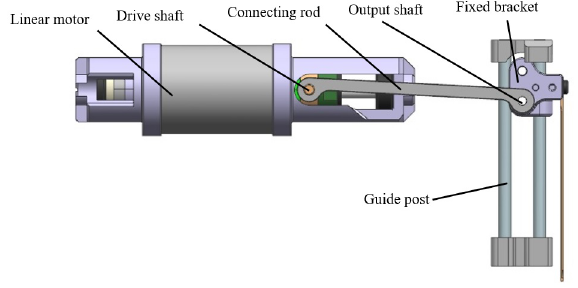
Fig. 13. Magnifying components of mechanism.